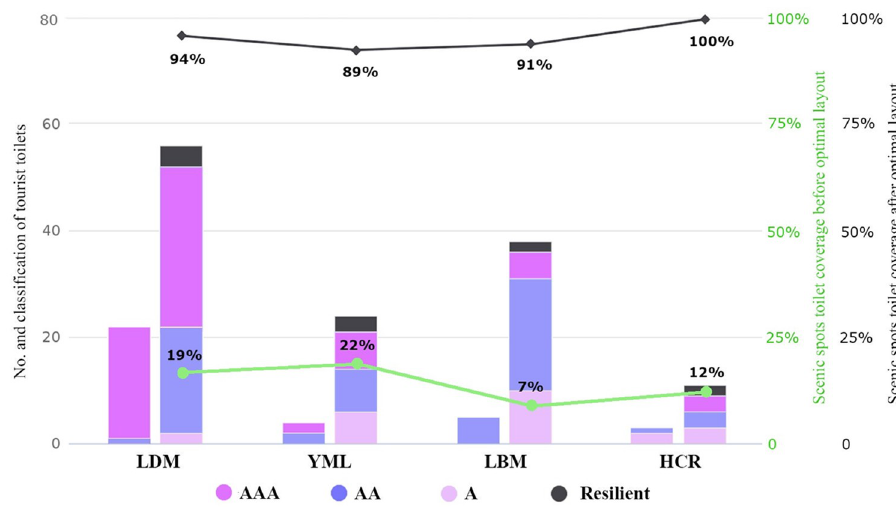
Fig 11. Statistics of tourist toilets in scenic areas before and after optimization (copyright hold by the